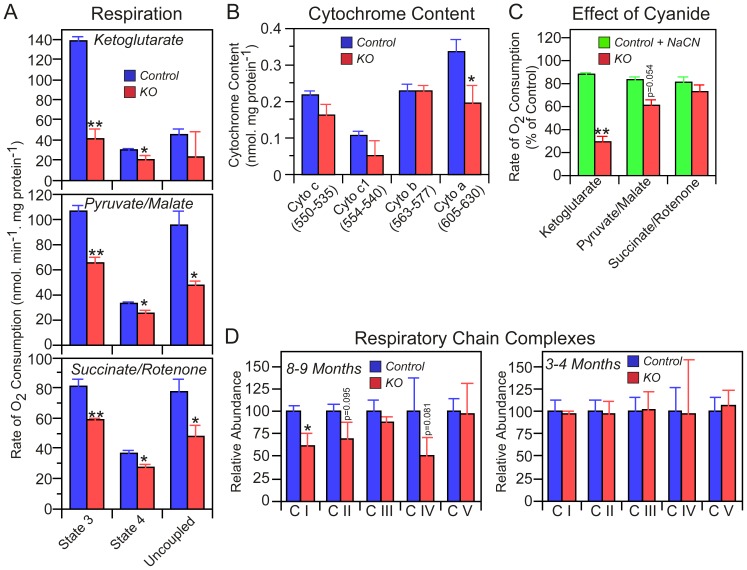
Respiratory properties of skeletal muscle mitochondria.A: Oxygen consumption by mitochondria isolated from mice 8–9 months following treatment with tamoxifen. Values are means ± SEM (n = 4). “State 3” indicates respiration rates during ATP synthesis, “State 4” is in the presence oligomycin to inhibit ATP synthesis, and “uncoupled” is in the presence of carbonyl cyanide p-[trifluoromethoxy]phenylhydrazone to measure maximal respiration rates. The uncoupled rate with α-ketoglutarate is low because the enzyme was depleted of ADP, its allosteric activator; additional data (not shown) demonstrated that addition of ADP increased the uncoupled rate. B: Cytochrome content: values are means ± SEM (n = 5). C: Respiration of mitochondria treated with NaCN. NaCN (15 µM) was added to control mitochondria to mimic the 40% reduction in cytochrome oxidase observed in mitochondria from KO compared to control mice. Respiration, measured in the presence of ketoglutarate, pyruvate+malate, and succinate+rotenone, was compared with that of untreated mitochondria from KO mice. D: Abundance of subunits of the five respiratory chain complexes in mitochondria from KO (n = 3) relative to HF control (n = 4) mice. Western blotting was used to detect subunits of complexes I (NDUFB8), II (30 kDa subunit), III (core protein 2), IV (subunit 1) and V (alpha subunit), employing primary antibodies obtained from Mitosciences. The antigen targets represent labile subunits that are degraded when not assembled into the appropriate complex and thus are representative of the abundance of the fully assembled complexes. Mitochondria were isolated from two groups of mice 8–9 months and 3–4 months following treatment with tamoxifen. Statistical significance in unpaired t-tests is indicated by *p>0.05 or **p<0.005; for p values of marginal significance actual values are shown.